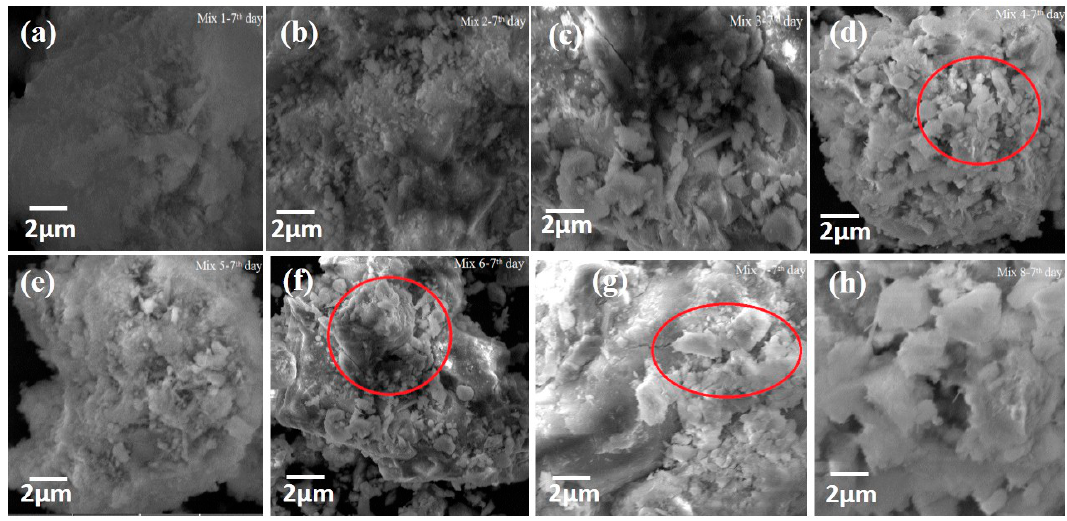
Figure 7. ( a – h ) SEM images represent the morphologies of Mixes 1 to 8 of hydration after the 7th day. Fibers 2017 , 5 , 39 9 of 12